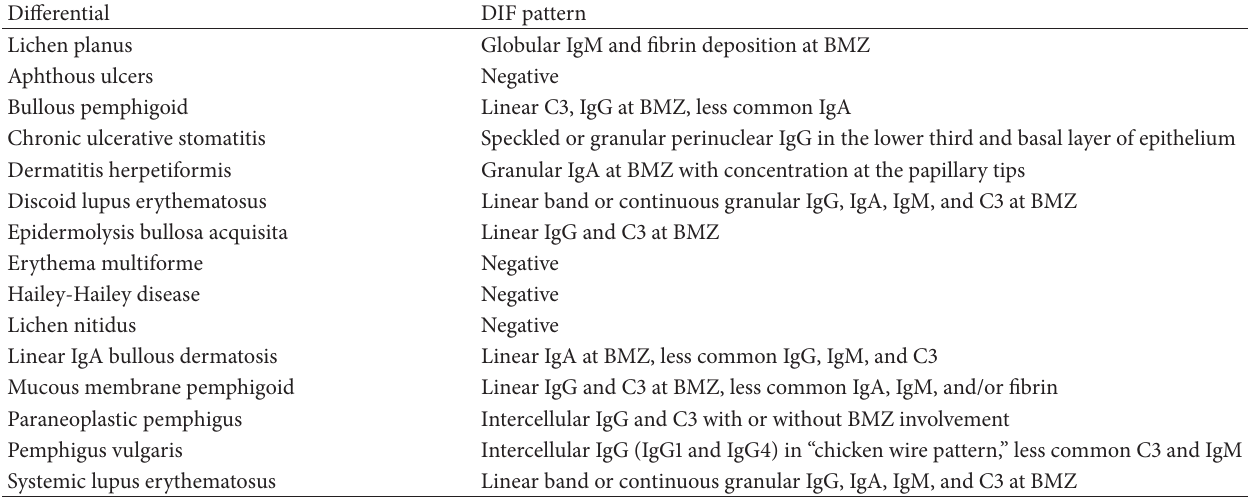
Table 5: The pattern of DIF results of potential differential diagnoses of lichen planus. Differential